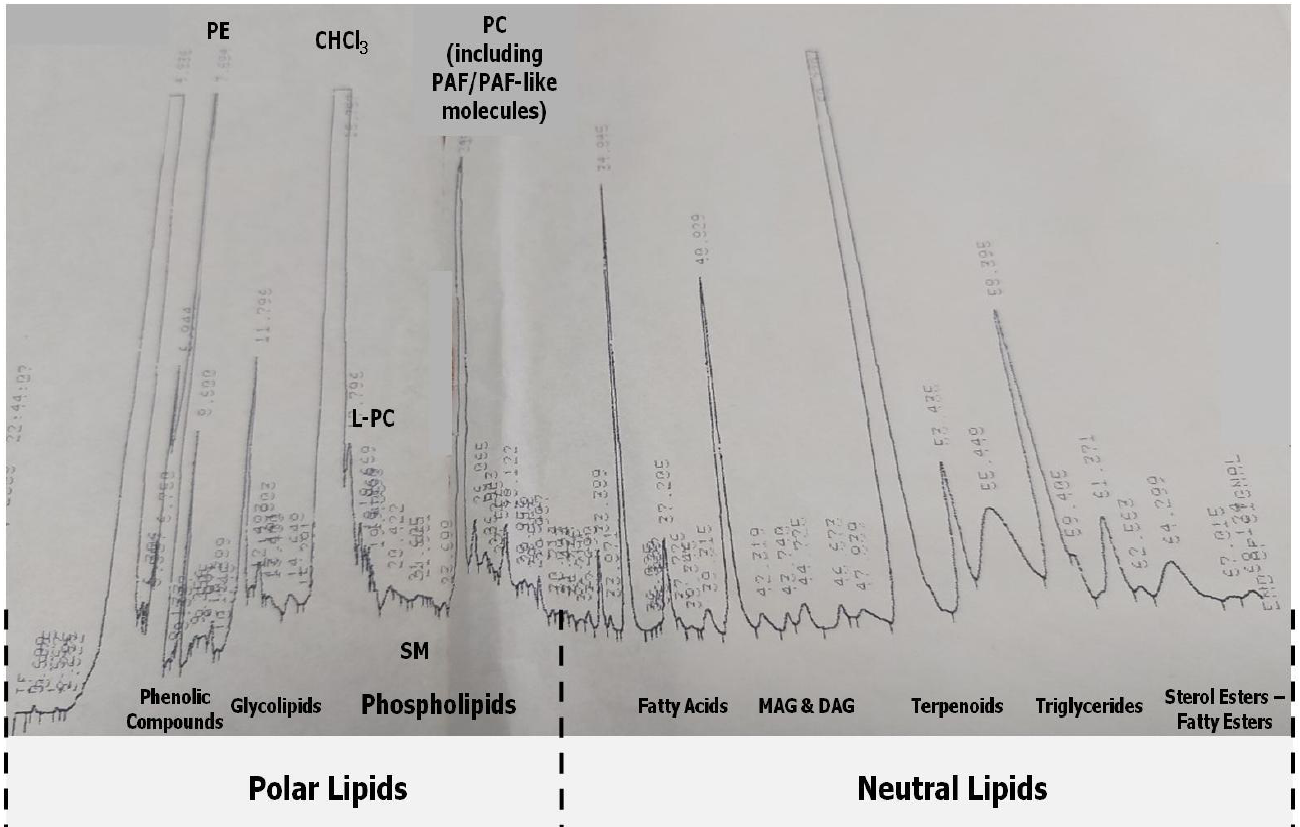
Figure 1. A representative chromatograph of the HPLC-separation of the TL extracts from fresh squeezed juices of Navalina and Sanguine orange varieties and of Clementine mandarins, as well as from their remaining by-products (peels’ wastes). The more polar phenolic compounds from all these TL extracts are eluted first (at 2 – 8 min) followed by the amphiphilic polar lipids (PL), such as glycolipids (at 8 – 14 min) and L-PC, SM and PC (at 14 – 30 min). The elution of the more Neutral li- pids (NL) starts after 30 min, with essential citrus oils being the first to be eluted (30 – 40 min) fol- lowed by fatty acids, mono-/di/alcylglycerols (MAG and DAG), triglycerides and fatty/sterol es- ters. Radioactive 3 H-PAF and standard semi-synthetic cold PAF are usually eluted at RT of 23 – 28 min respectively, while PC-molecules with PAF-like activity are eluted at similar RT (23 – 30 min), depending on the length of the carbon chains of their fatty acids. Elution times of standard phos- pholipids subclasses are also shown (PC: Phosphatidylcholine, L-PC: Lyso- Phosphatidylcholine, SM: Sphingomyelin).